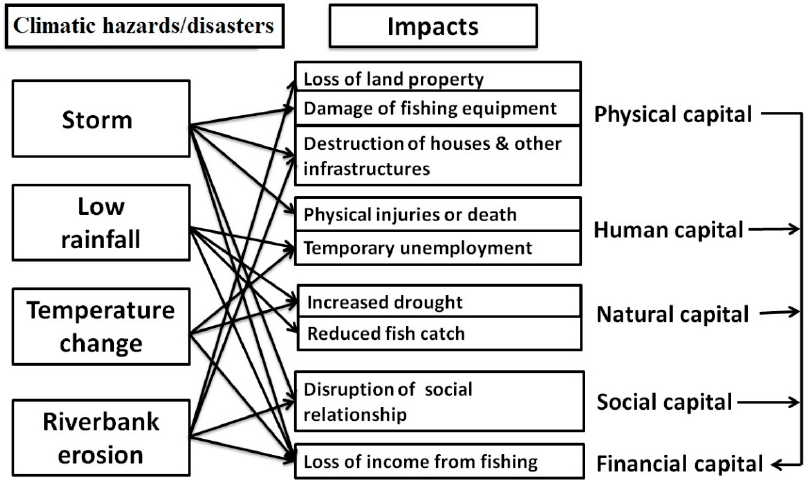
Figure 4. Impacts of climatic hazards/shocks on different livelihood capitals of fishers dependent on the Padma River fisheries, Bangladesh. Source: Author’s own presentation.